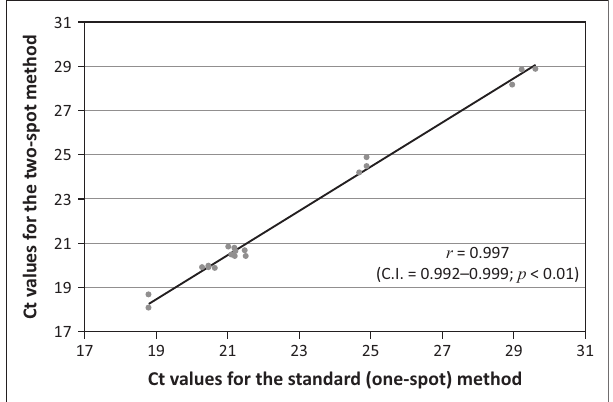
FIGURE 3: Validation experiment correlations between Ct values for the standard (one-spot) and two-spot specimen processing methods. Twenty positive and 20 negative specimens were processed by both the two-spot and the standard one-spot methods of pre-analytical specimen processing. The scatterplot shows the Ct values obtained during real-time PCR amplification of the positive specimens. An overlaid line of linearity and Pearson’s correlation coefficient of 0.997 shows the correlation between the Ct values for each of the specimen processing